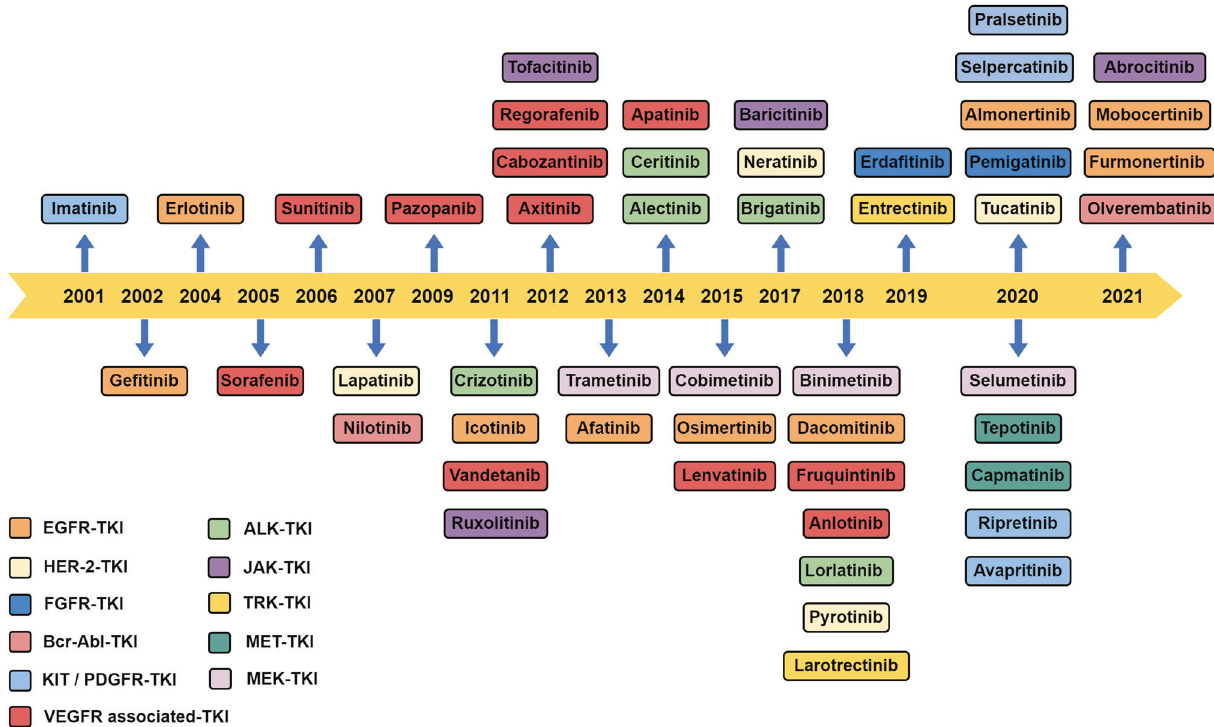
Fig. 1 The main TKI drugs on the market in recent 20 years. The main TKIs approved in chronological order by China ’ s National Medical Products Administration, Japan ’ s Ministry of Health, Labour and Welfare and the US Food and Drug Administration in recent